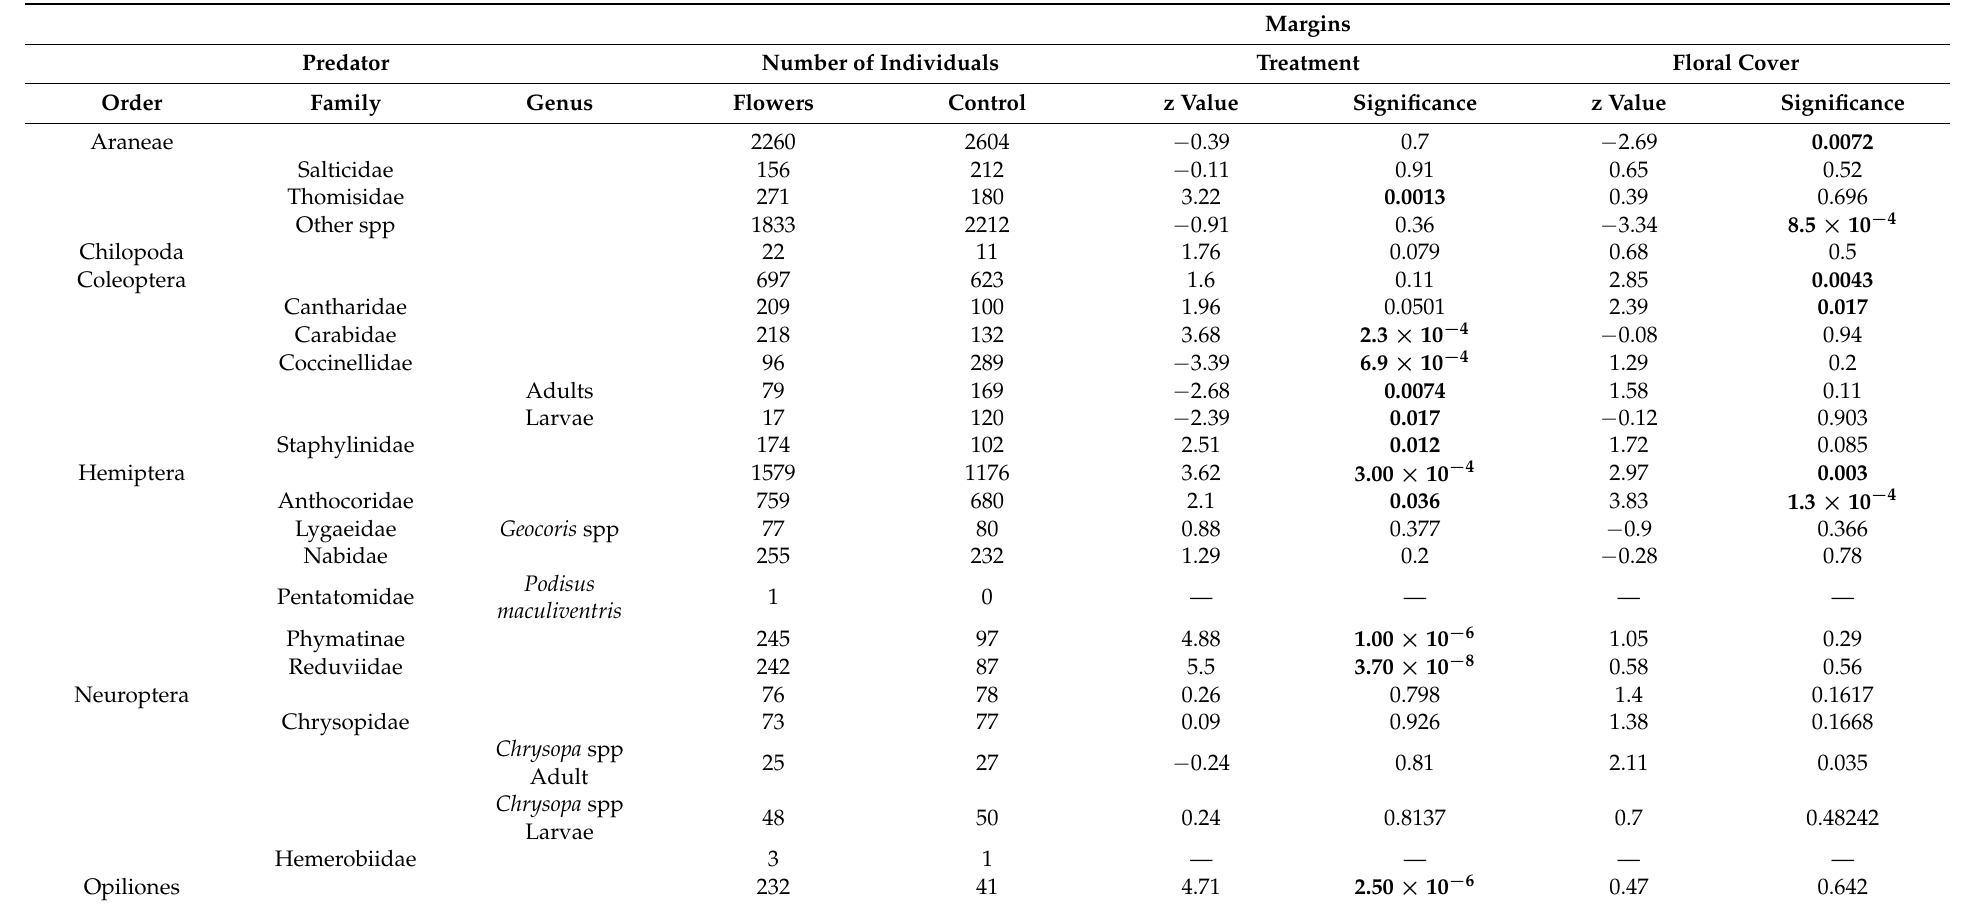
Table 2. Predator abundance, z values, and significance by treatment and floral cover within field margins. Bolded values are significant ( p < 0.05). Taxa with fewer than 10 individuals were not